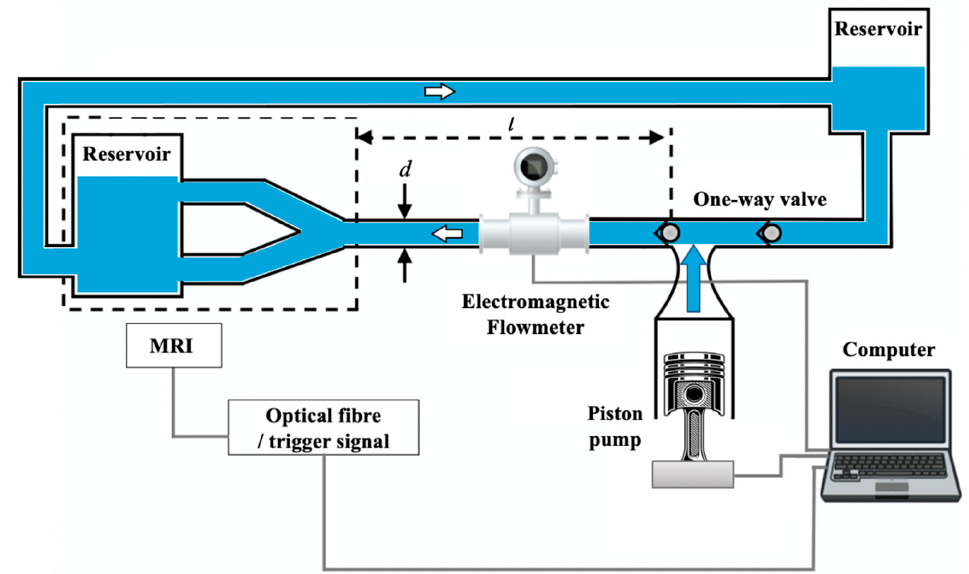
Figure 2. Example of experimental set-up for the study of arterial bifurcation in [25]. The tubing diameter is d = 20 mm and the distance l = 4.5 m.